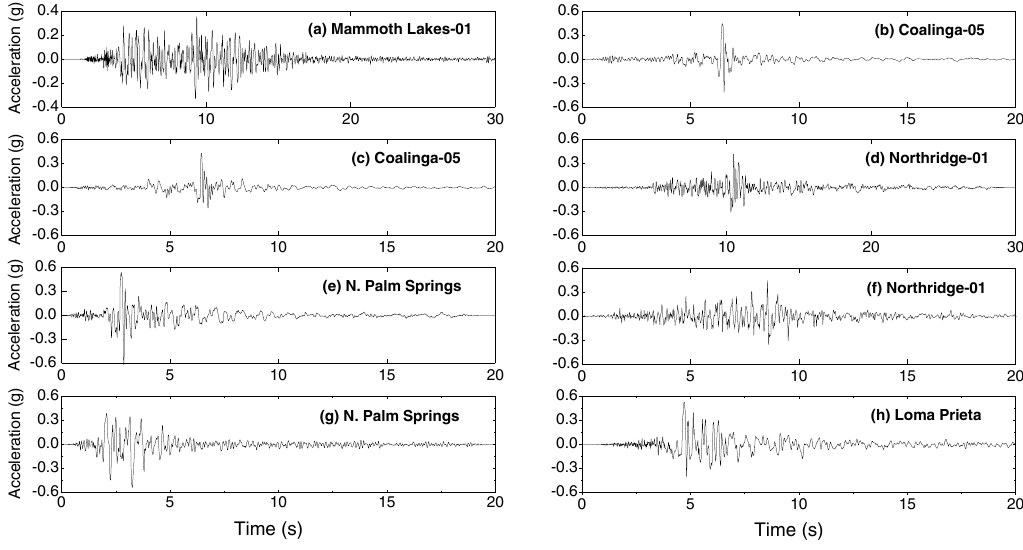
Figure 11. Eight time history recommendations for Taichung (site c) with DSHA calculations and the NGA strong-motion